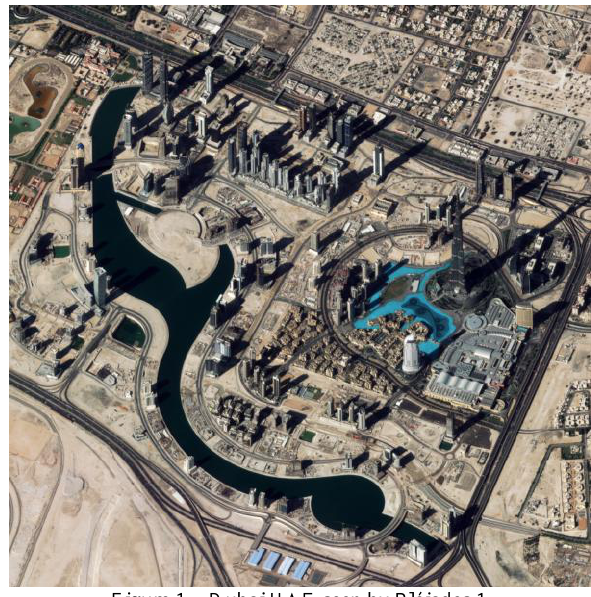
Figure 1 – Dubai UAE seen by Pléiades 1 Pansharpened product prototype from the commissioning phase. (c) CNES 2011 – distribution Astrium Services / Spot